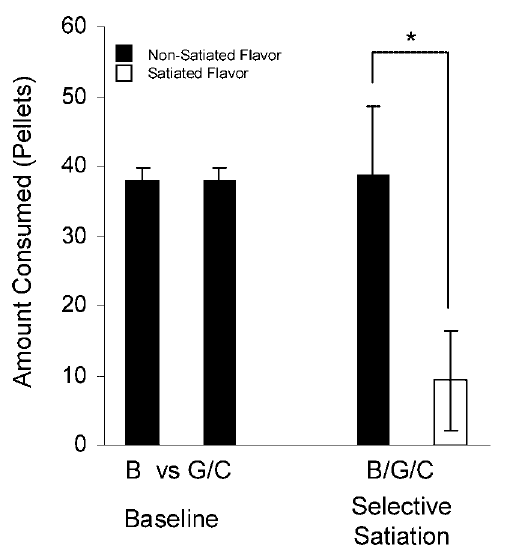
Figure 2. Taste preference testing for banana (B) versus grape (G) or chocolate (C)-flavored sucrose pellets . Food-deprived rats were tested in preference tests in which rats were given banana and chocolate or banana and grape flavored sucrose pellets in their home cage for 5minute over 3days. There was no difference in consumption across these preference tests (baseline, F(1,95) = 0.017, p = 0.89). On subsequent days, rats were given access to one of the flavors (banana, grape, or chocolate) for 20minute in an unlimited quantity, then they were presented with the satiated and another non-satiated flavor together. Even though the different flavors were of equal value, the rats preferred the new flavor after satiation (selective satiation, F(1,47) = 41.1, p<0.0001) (*,